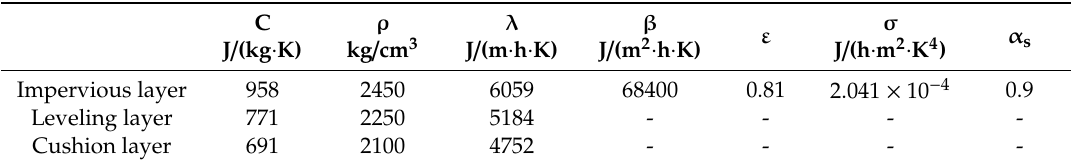
Table 4. Thermal parameters used for the calculation [23,24]